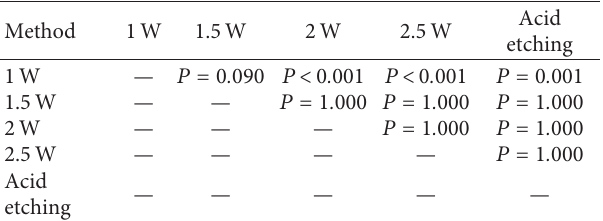
Table 5: Pairwise comparisons between the different etching methods.